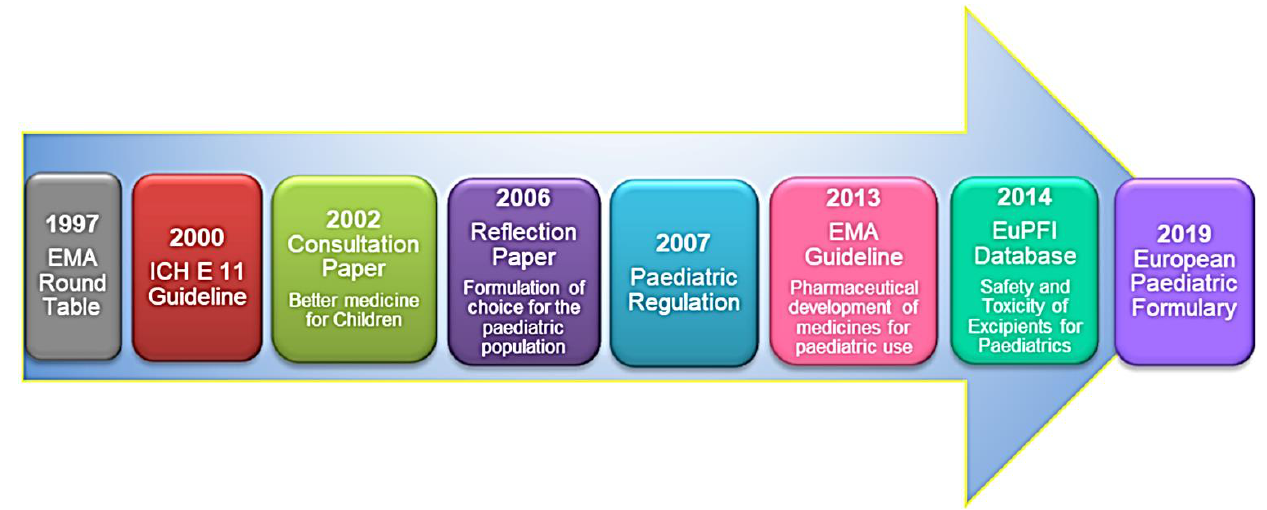
Figure 1. The European path of pediatric formulations.